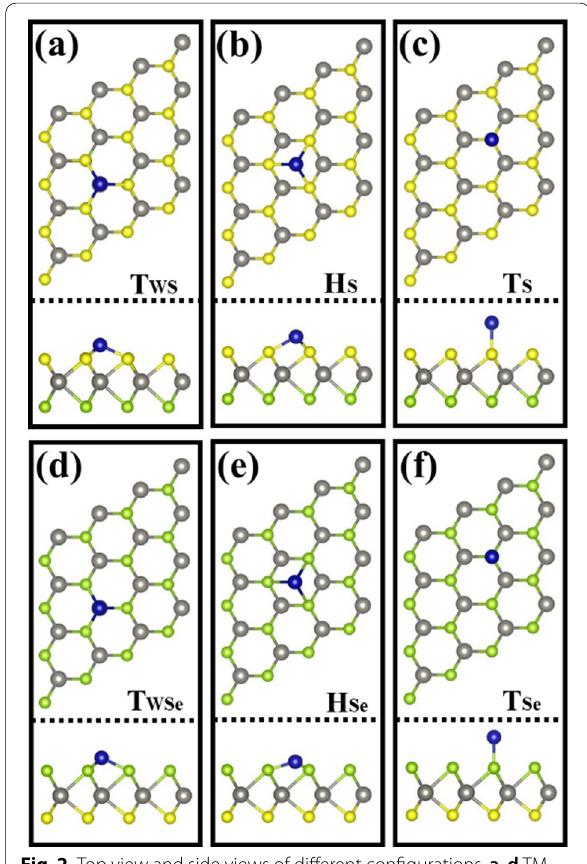
Fig. 2 Top view and side views of different configurations. a , d TM atom locates on the top of W atom; b , e TM atom locates on the hollow site; c , f TM atom locates on the top of S(Se) atom